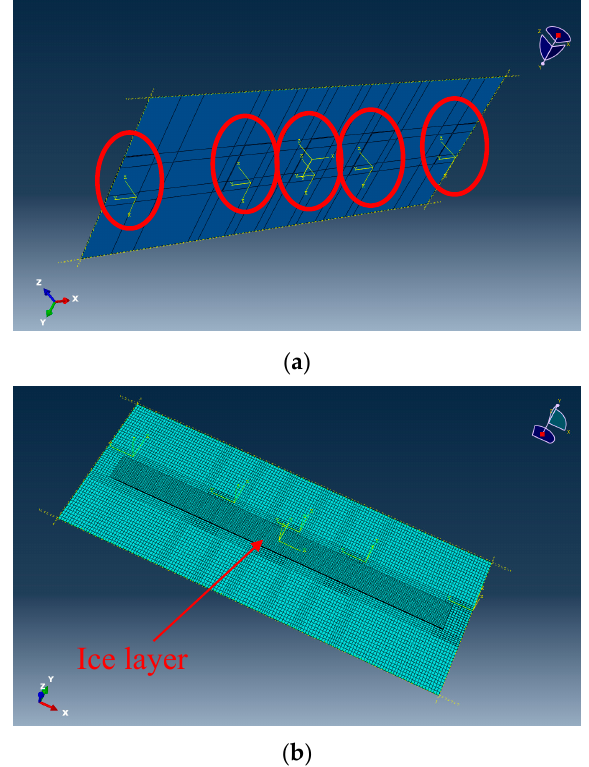
Figure 1. ( a ) Five actuator patches tied to the flat plate ( b ) Ice layer on the flat plate in numerical model.